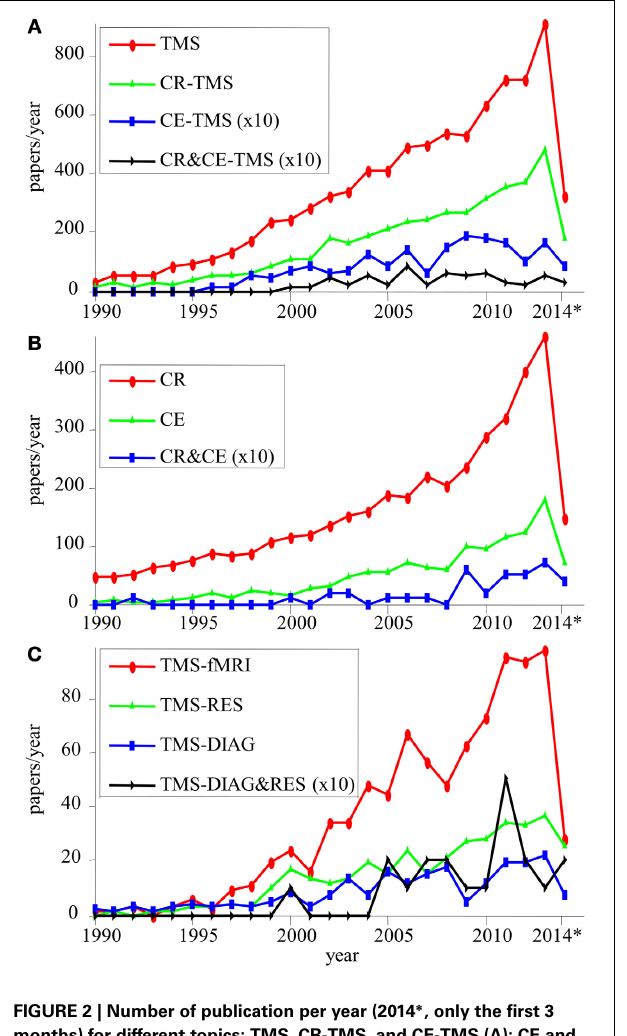
FIGURE 2 | Number of publication per year (2014 ∗ , only the first 3 months) for different topics: TMS, CR-TMS, and CE-TMS (A); CE and CR (B); applications of TMS in research (TMS-RES), diagnostic (TMS-DIAG) and concurrent TMS-fMRI (C). Results for topics represented by small numbers of publications are multiplied by 10 ( × 10). We show also results for conjunctions of topics: (CR&CE-TMS) (A) ; (CR&CE) (B) ; (TMS-DIAG&RES) (C)